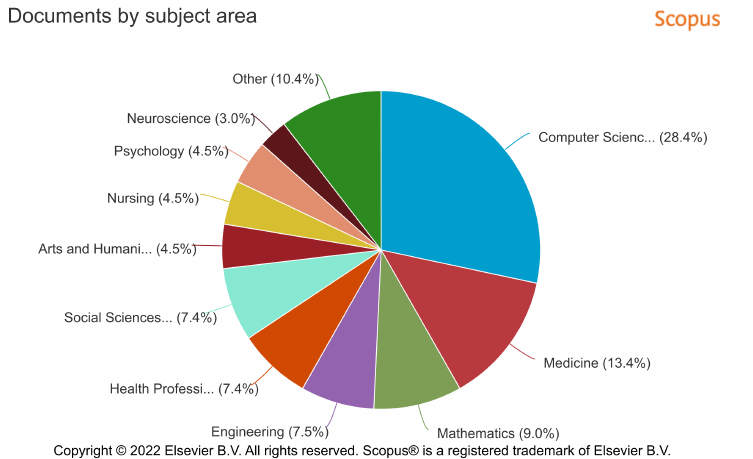
Figure 3. Percentage of documents by subject